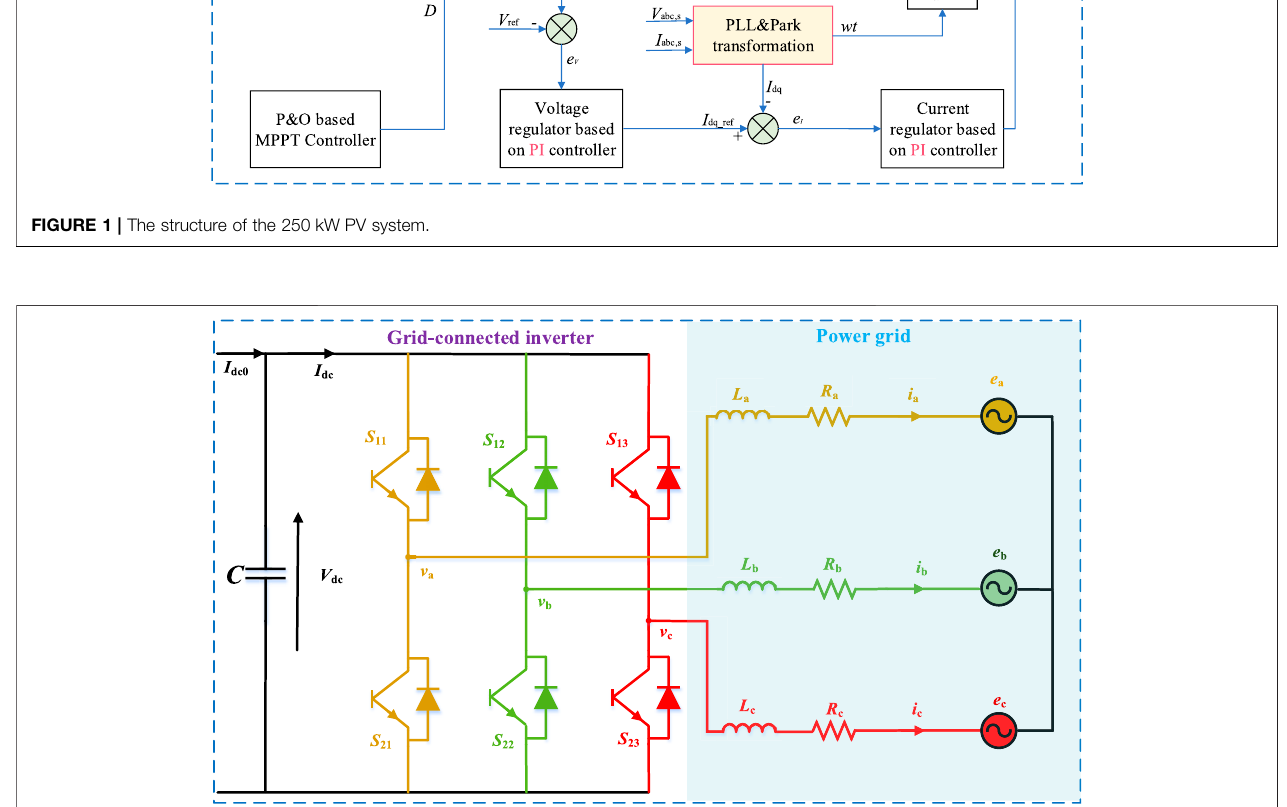
FIGURE 2 | Schematic diagram of a three-phase grid-connected PV